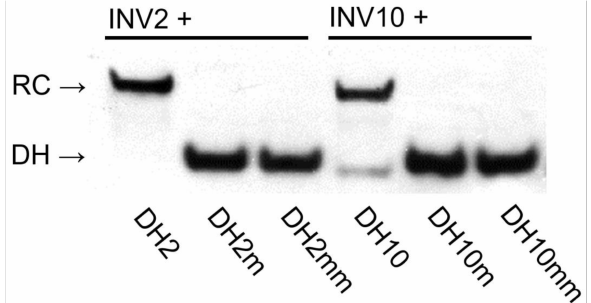
Figure 5. Binding specificity of Invader probes. A 100-fold molar probe excess was incubated with corresponding DNA hairpins featuring stems of identical sequence or differing in sequence at one (“m”) or two positions (“mm”) relative to the probes (37 ◦ C, 15 h). For sequences of DNA hairpins, see Table S6. Conditions are as described in Figure 3. Data previously shown in [23]—reproduced with permission from the Royal Society of